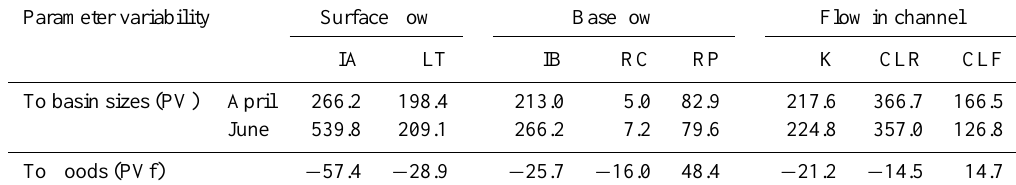
Table 3. Parameter sensitivity indicators (%).